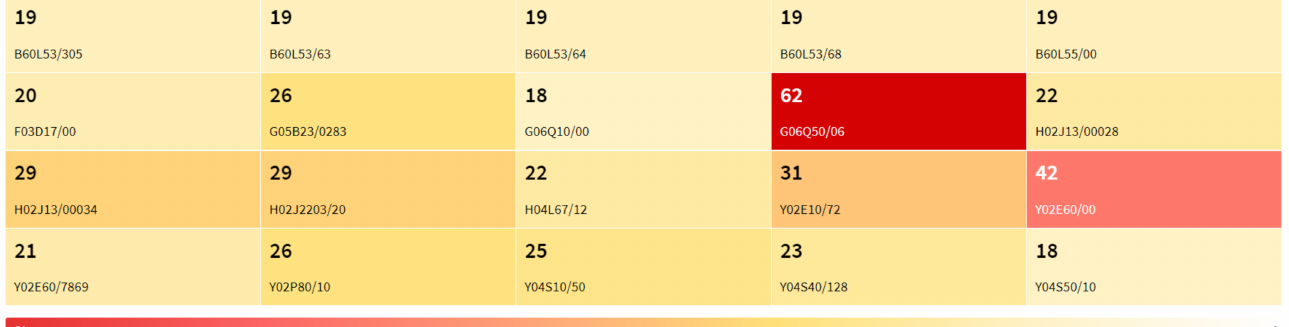
Figure 10. Top 20 CPC classification codes of patents.